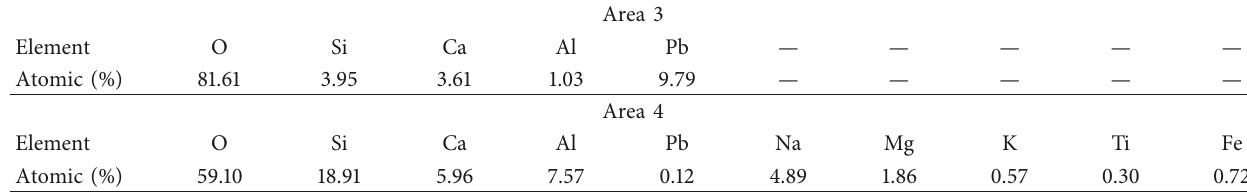
Table 8: EDS analysis of P2